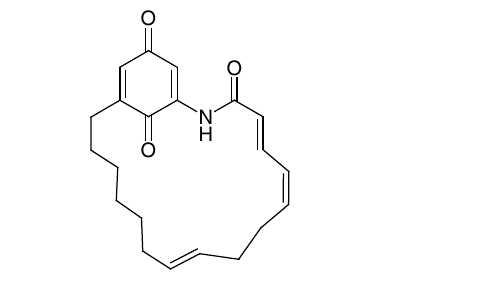
Figure 3. Structure of the geldanamycin macrocycle maintained as rigid during molecular